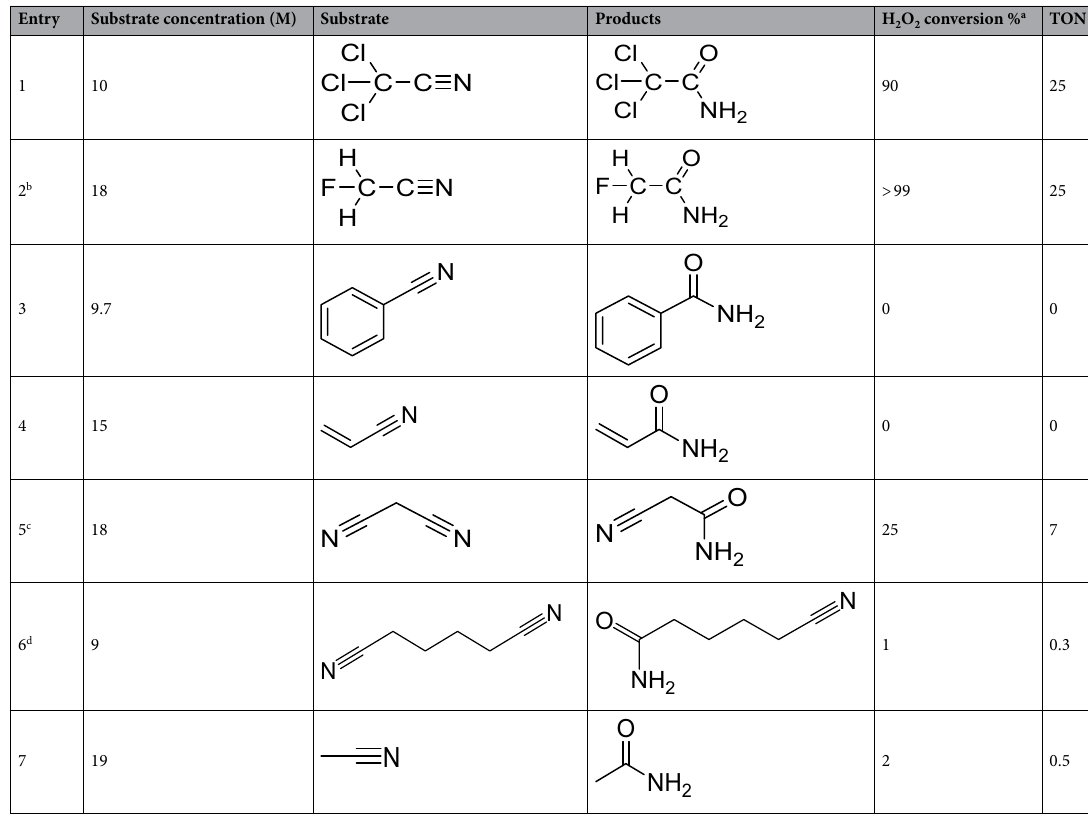
Table 1. Nitrile hydrolysis to amide by copper complex. Reaction conditions: Each entry includes 57.5 eq (57.5 mmoles) of nitriles (except 2 and 6), H 2 O 2 (1 mmol), Complex (BF 4 ) (0.04 mmol, 4% of H 2 O 2 ), time (2 h), room temperature. a Conversion calculated based on oxidant (H 2 O 2 ) as the limiting reagent. b FCH 2 CN (30 mmol). c Malononitrile melts at 32 °C, the reaction was carried out at 35 °C. d Adiponitrile (15